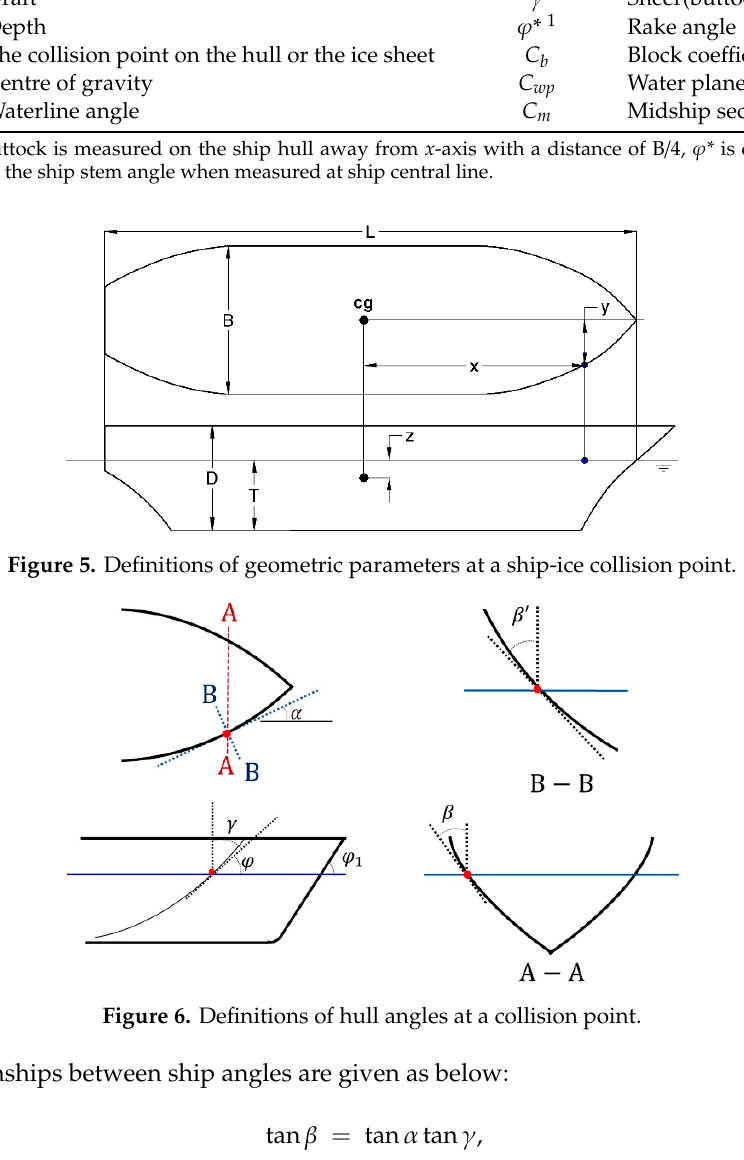
Table 1. Ship parameters.